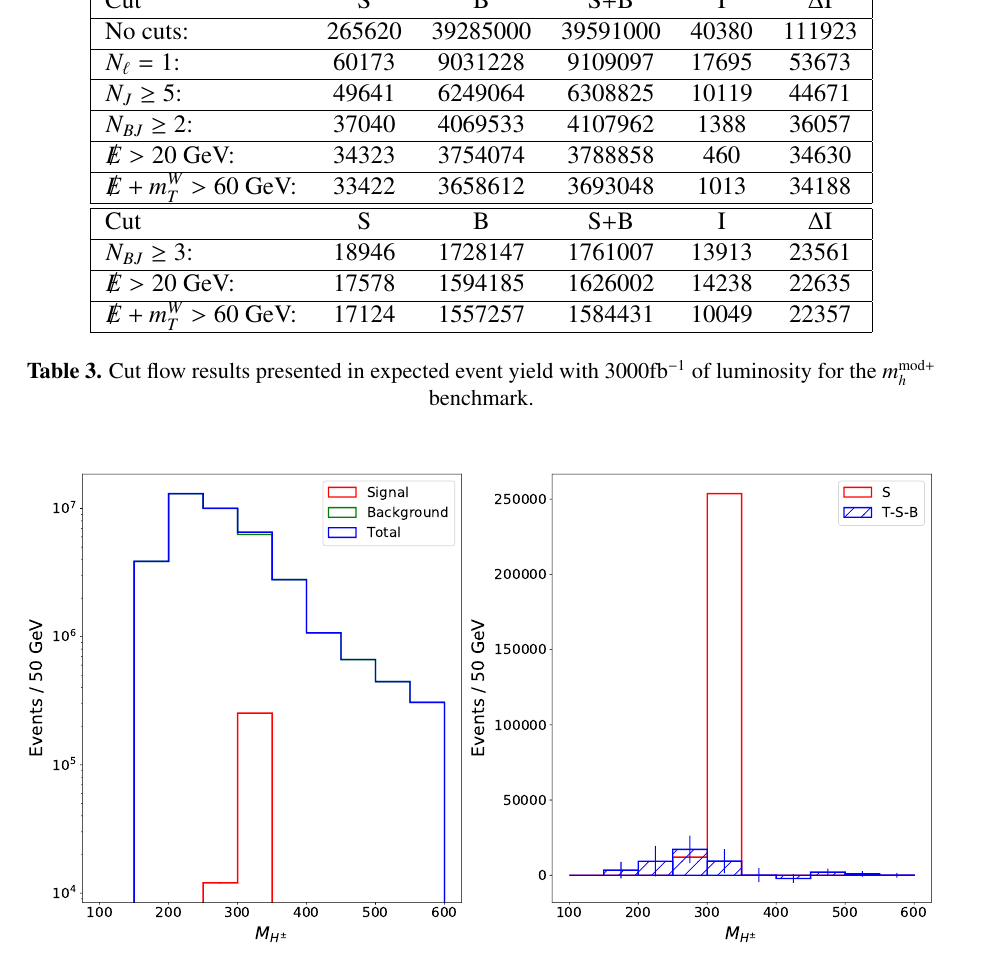
Figure 6. The charged Higgs invariant mass distribution of the signal, background and total samples (left) and interference and signal (right) at parton level and without cuts in the m mod +